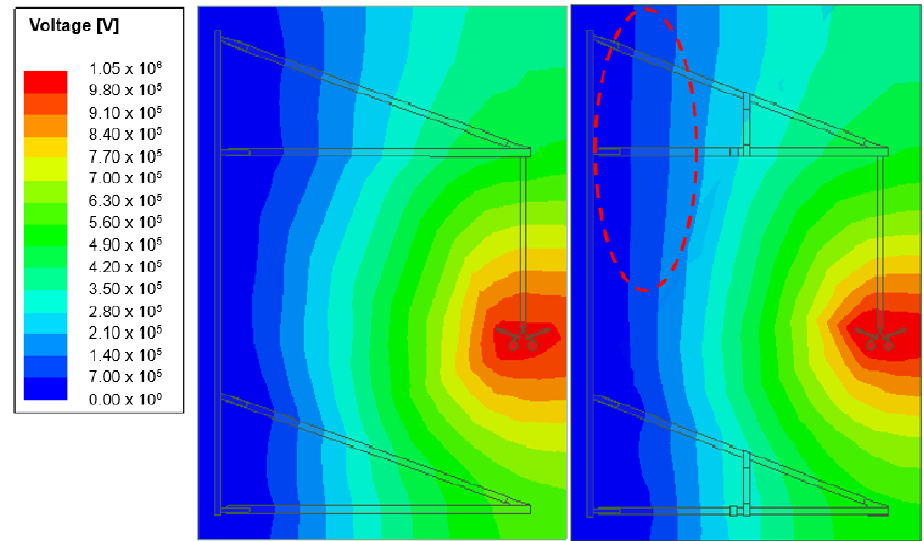
Figure 8. Equal-potential distribution for the case with a non-pivoted insulator under BIL voltage.